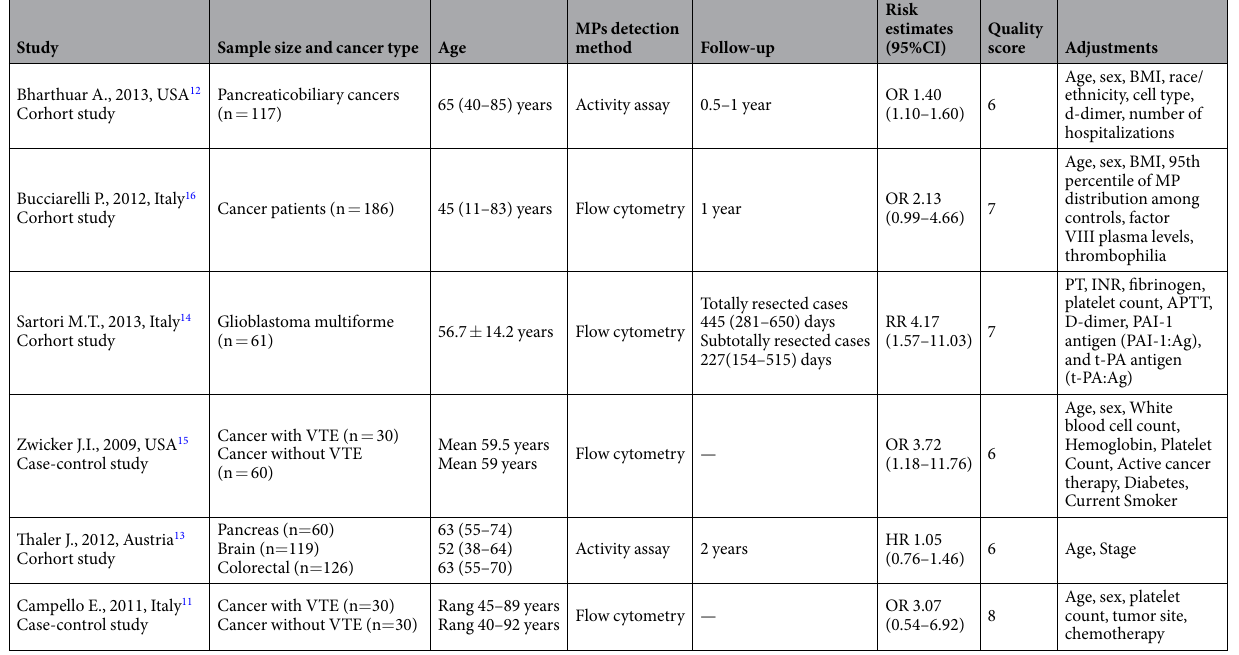
Table 1. The characteristics of studies in this meta-analysis. BMI body mass index; MP Microparticle; VTE Venous thromboembolism; PT thromboplastin time; INR international normalized ratio; APTT activited partial thromboplastin